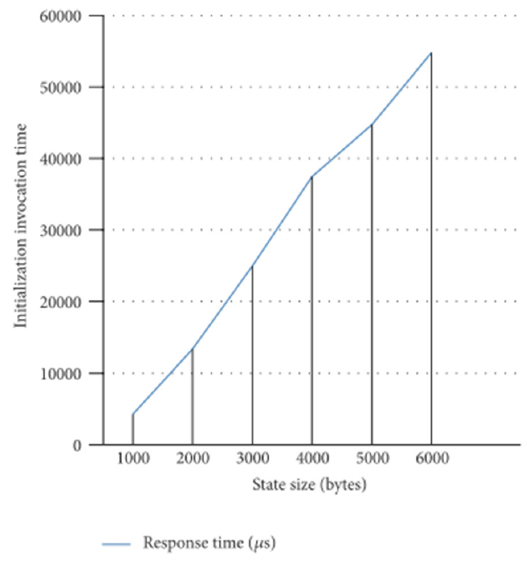
Figure 16 . State size influence in component initialization time.